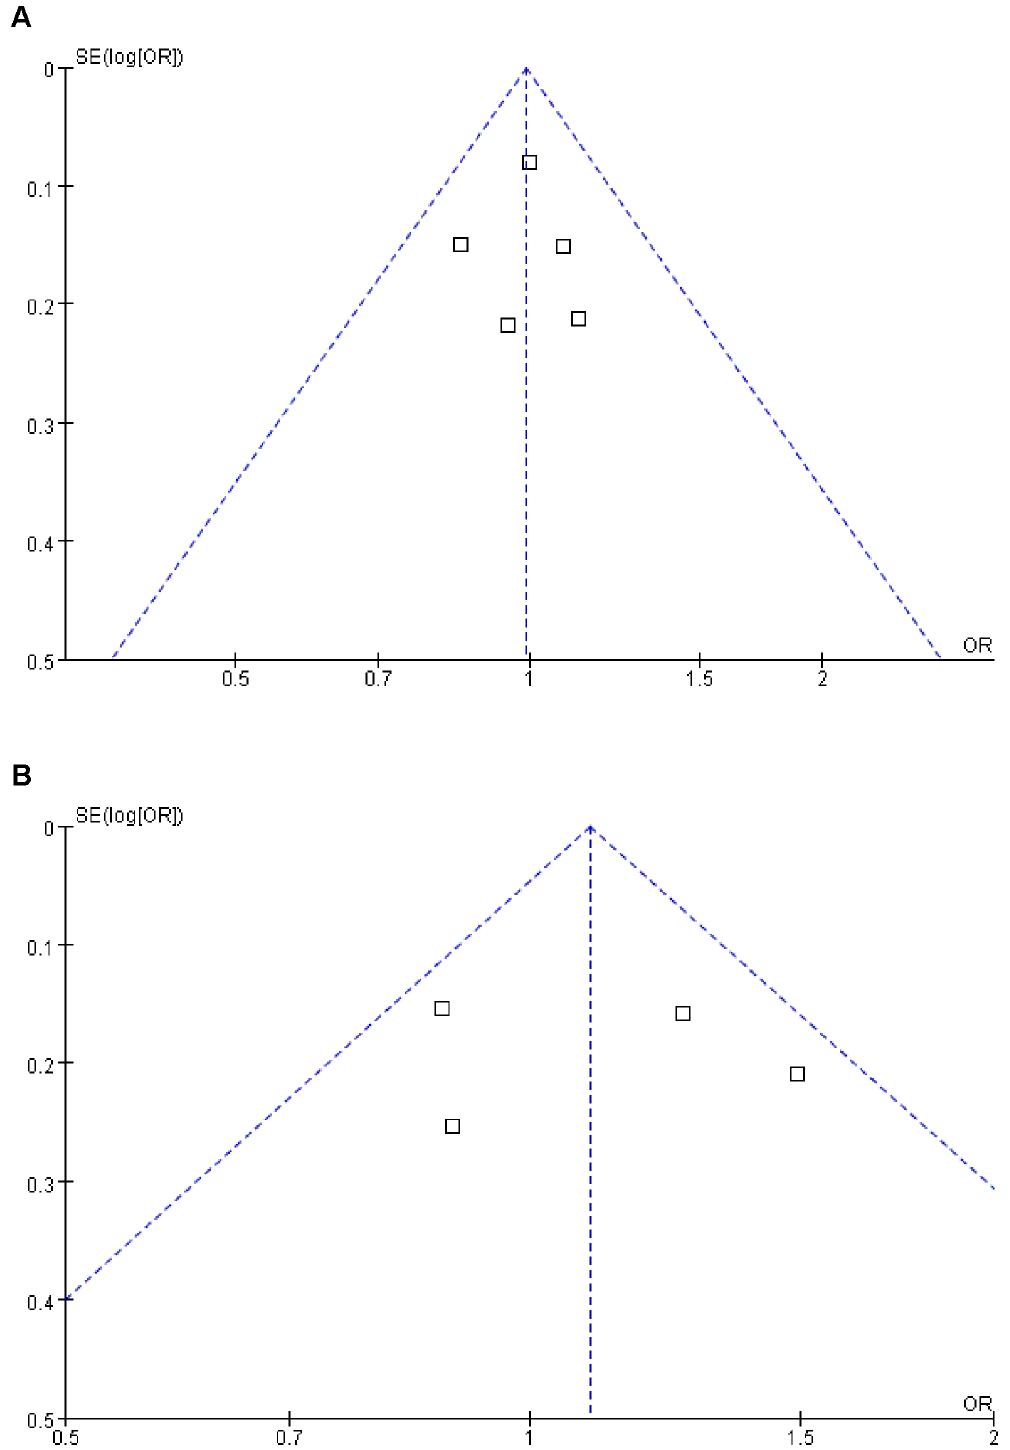
Figure 3. Funnel plots of IGFBP3 A-202C and Gly32Ala polymorphism and colorectal cancer risk. Part A, model: A-202C (AC Vs AA), t eager’s test =1.45, P eager’s test =0.28. Part B, model: Gly32Ala (GC Vs GG), t eager’s test =0.76, P eager’s test =0.35.